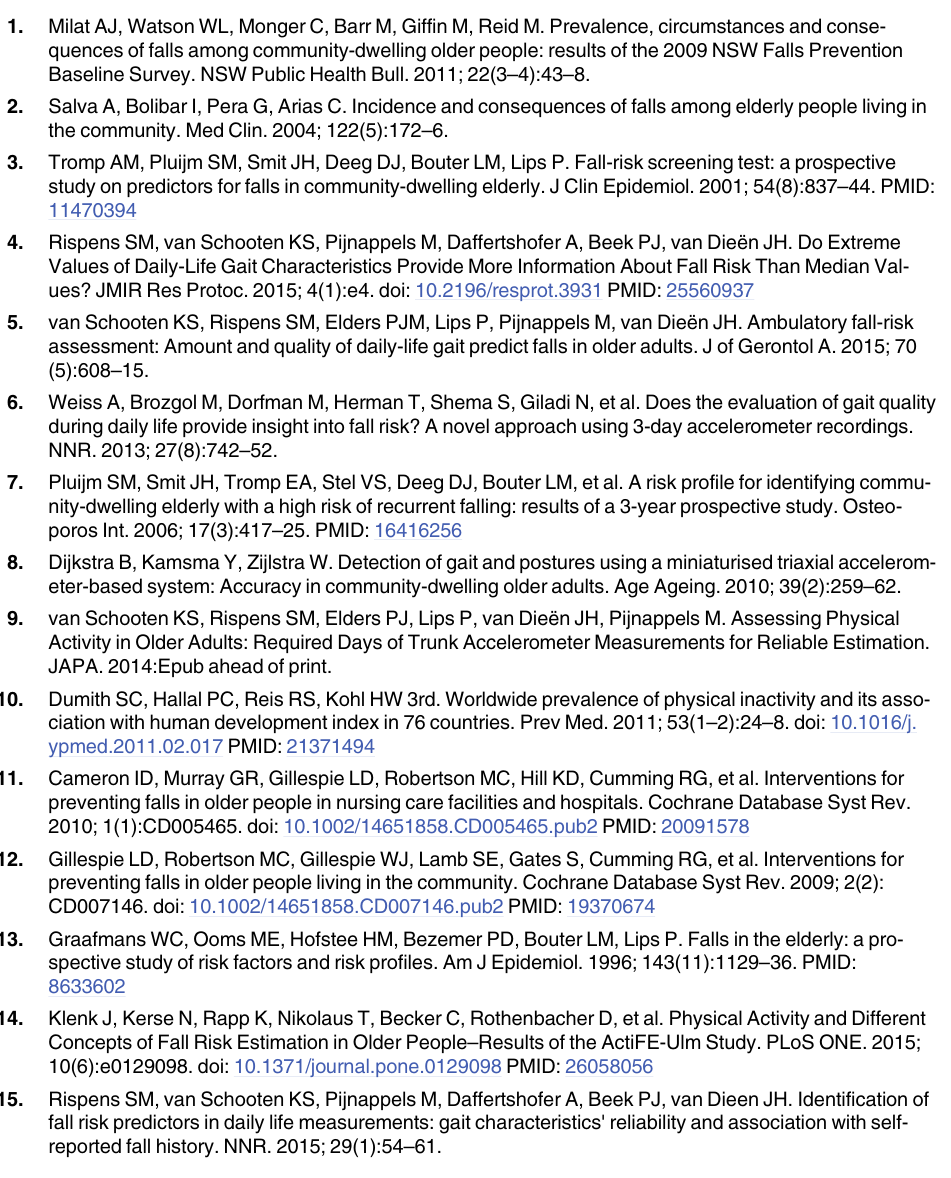
S2 Table. Loading of variables on Varimax-rotated principal components. Grey shade indi- cates loadings exceeding |0.3| which were used to coin